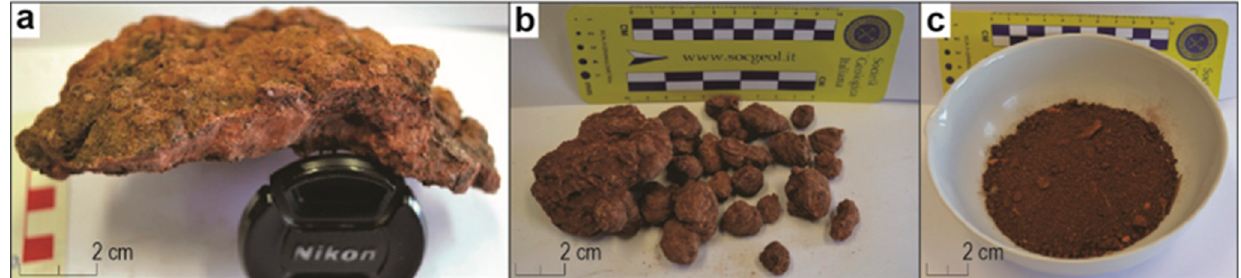
Figure 3. ( a ) Sample of calcite incrustation (see also Figure 2e); ( b ), ( c ) Samples of red calcite nodules and fine-grained material, respectively (see also Figure 2f), in the terra rossa